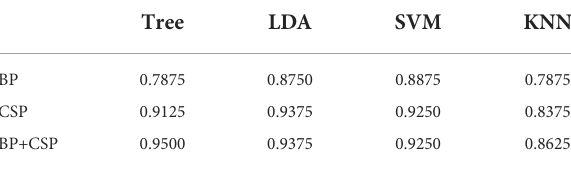
TABLE 3 Accuracies using LDA, SVM, KNN, and TREE classifiers.